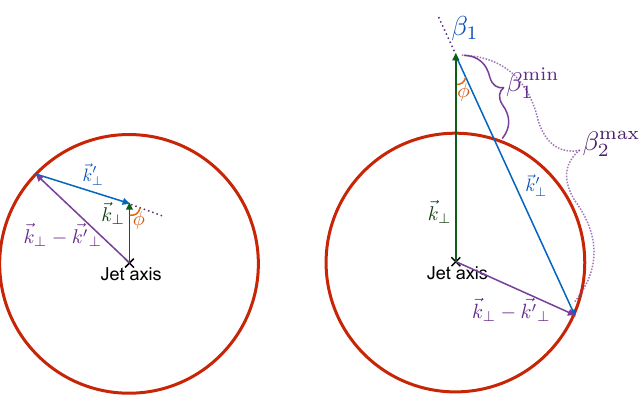
k < p T r (left) and j ? j